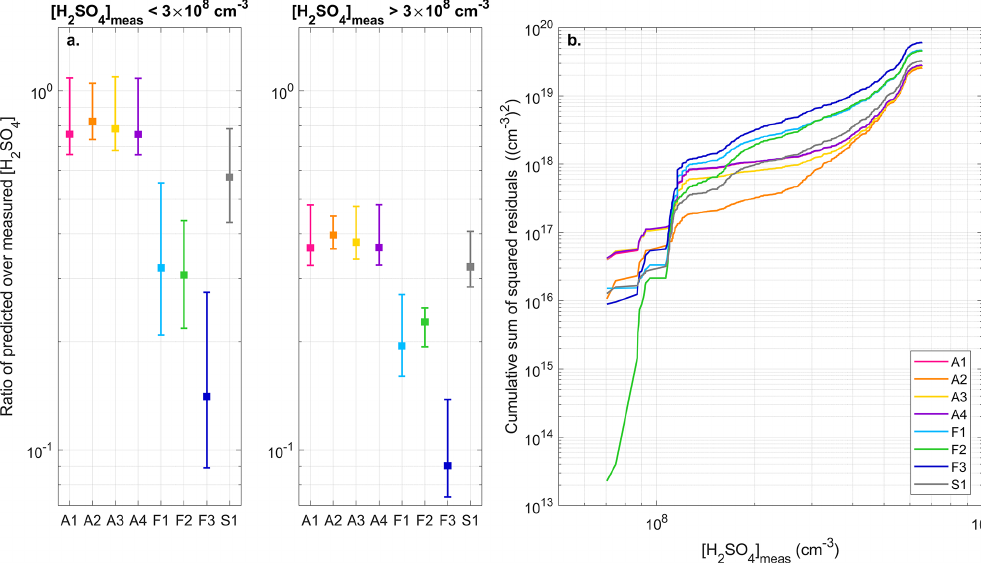
Figure 8. (a) Ratio between predicted and measured [H 2 SO 4 ], separately for the concentrations below and above 3 × 10 8 cm − 3 . For each proxy, the marker represents the median of the ratio, and the lower and upper limits of the error bars indicate the 25th and 75th percentiles respectively. (b) Cumulative sum of squared residuals associated with the different proxies.